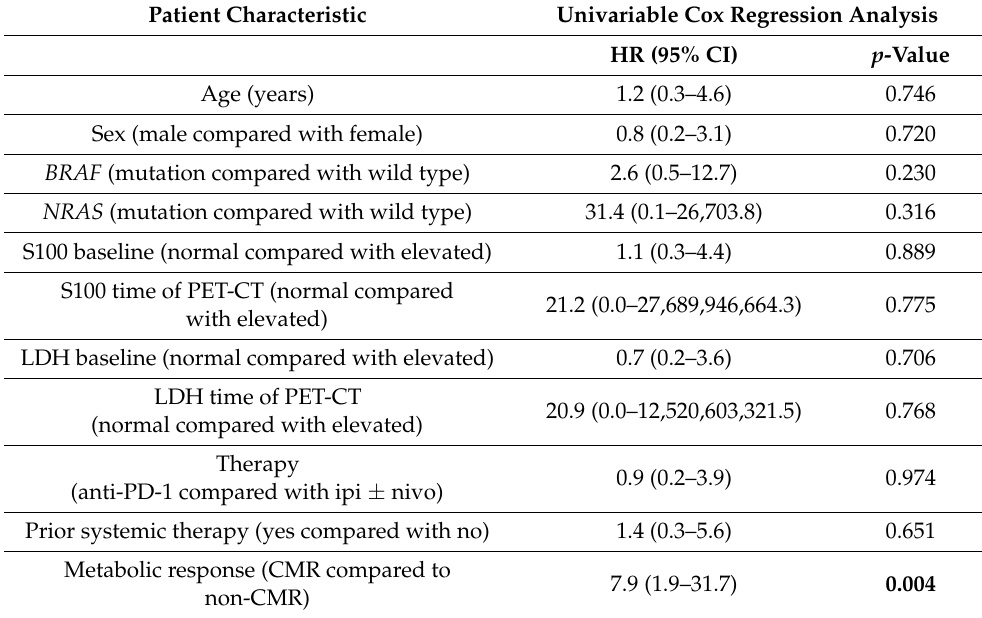
Table 3. Univariable Cox regression analysis for progression-free survival.